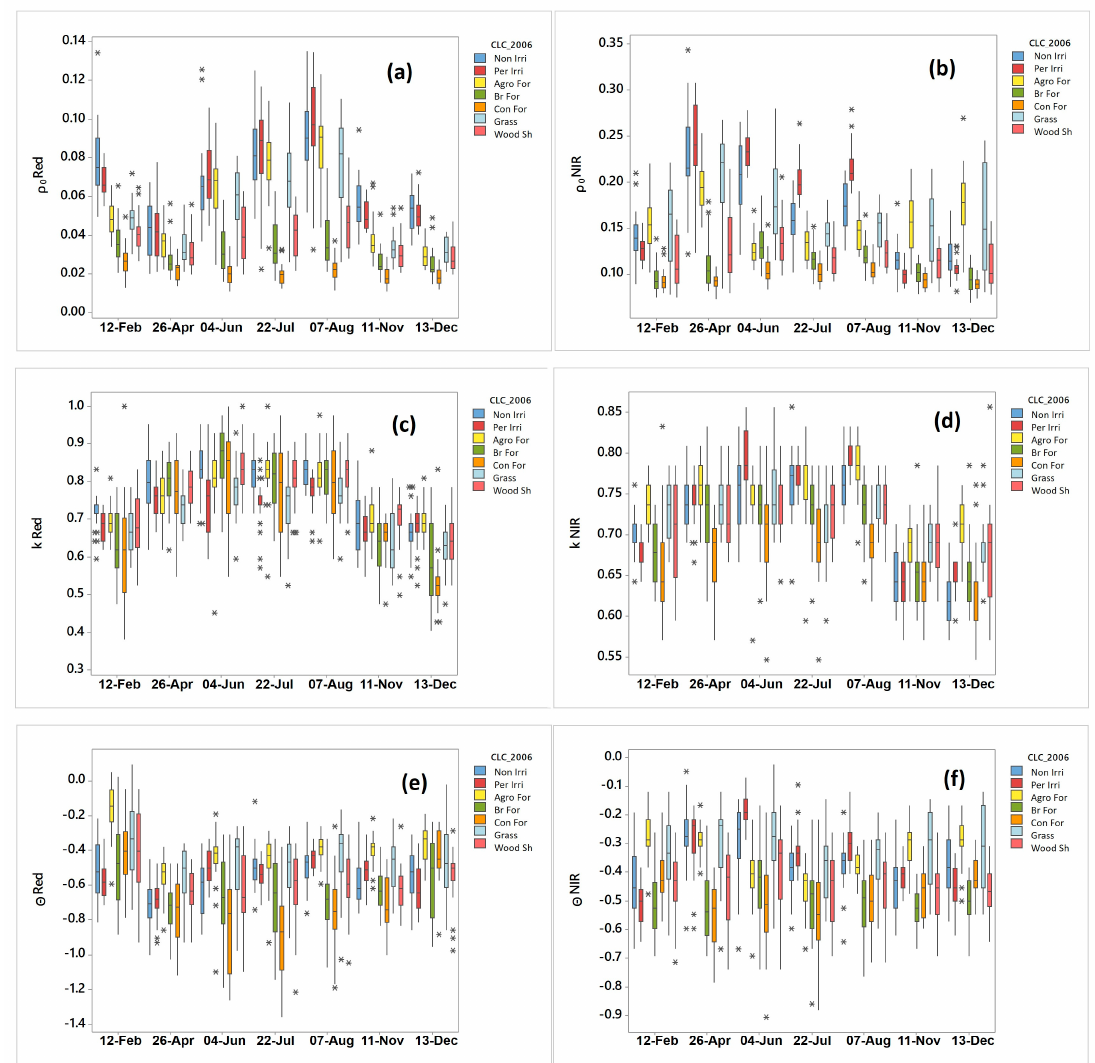
Figure 2. Rahman–Pinty–Verstraete–Martonchick (MRPV) parameter box plot showed by Co-ordination of Information on the Environment Land Cover (CLC) 2006 and MISR orbits captured for different dates. Outliers are identified by asterisks (*). ( a ) ρ 0-red boxplot; ( b ) ρ 0-near infrared (NIR) boxplot; ( c ) k-red boxplot; ( d ) k-NIR boxplot; ( e ) Θ -red boxplot; and ( f ) Θ -NIR boxplot. The ρ 0 red values from the MISR scenes ranged between 0.01 and 0.14, while those related to ρ 0 NIR were between 0.05 and 0.35. Meanwhile, the k red average values were from 0.35 to 1, and, for the k NIR, oscillated between 0.5 and 0.9. Finally, the average values of Θ in the spectral band of red were between –0.1 and –1.4, and those found in the NIR band were from 0 and –0.9 (see Figure